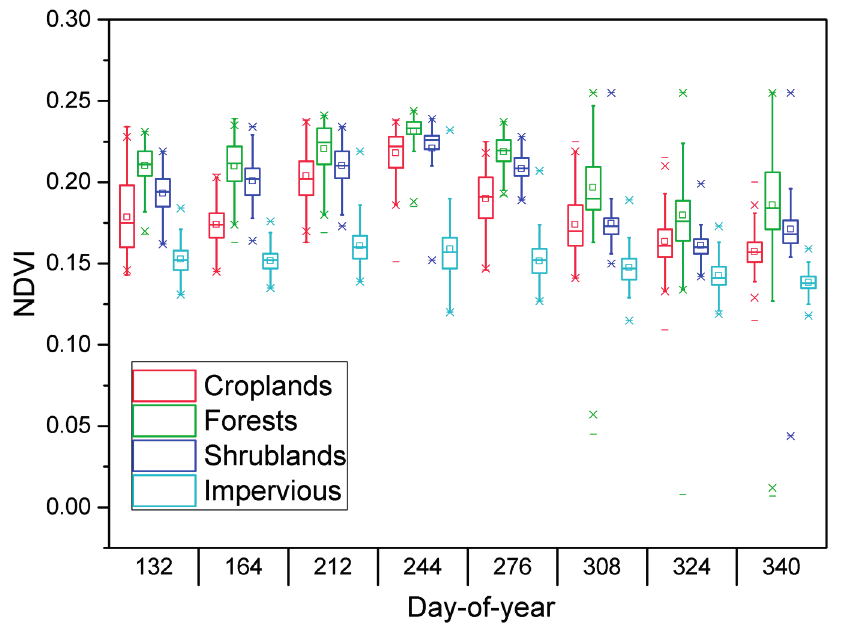
Figure 5. NDVI values for the validation samples of the four major land cover